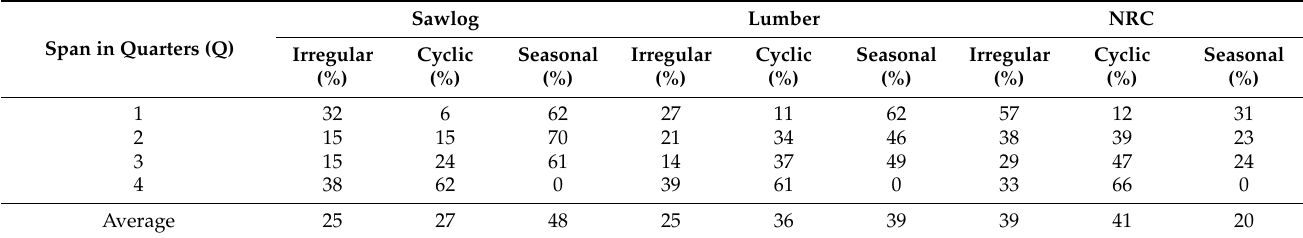
Table 7. Relative contribution of irregular, cyclic, and seasonal fluctuation in total variability of timber price and number of residential units completed (NRC).